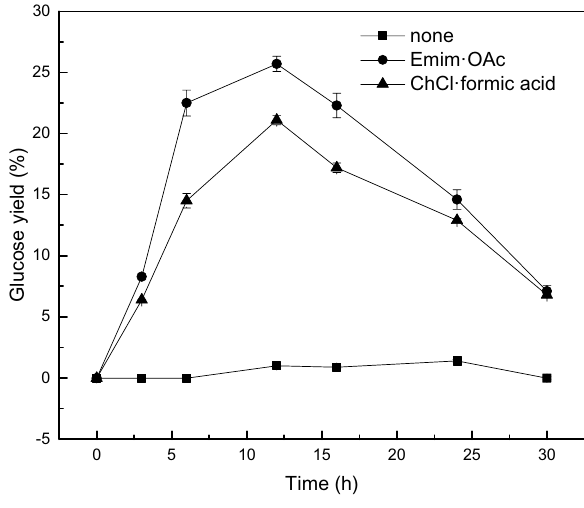
Fig. 13 Glucose yield from MCC reaction at different temperatures with Emim·OAc (closed symbols) and with ChCl·formic acid (open symbols) in a one-pot reaction. Reaction conditions: 0.1 g MCC, 0.1 g solid acid catalyst and 4 mL